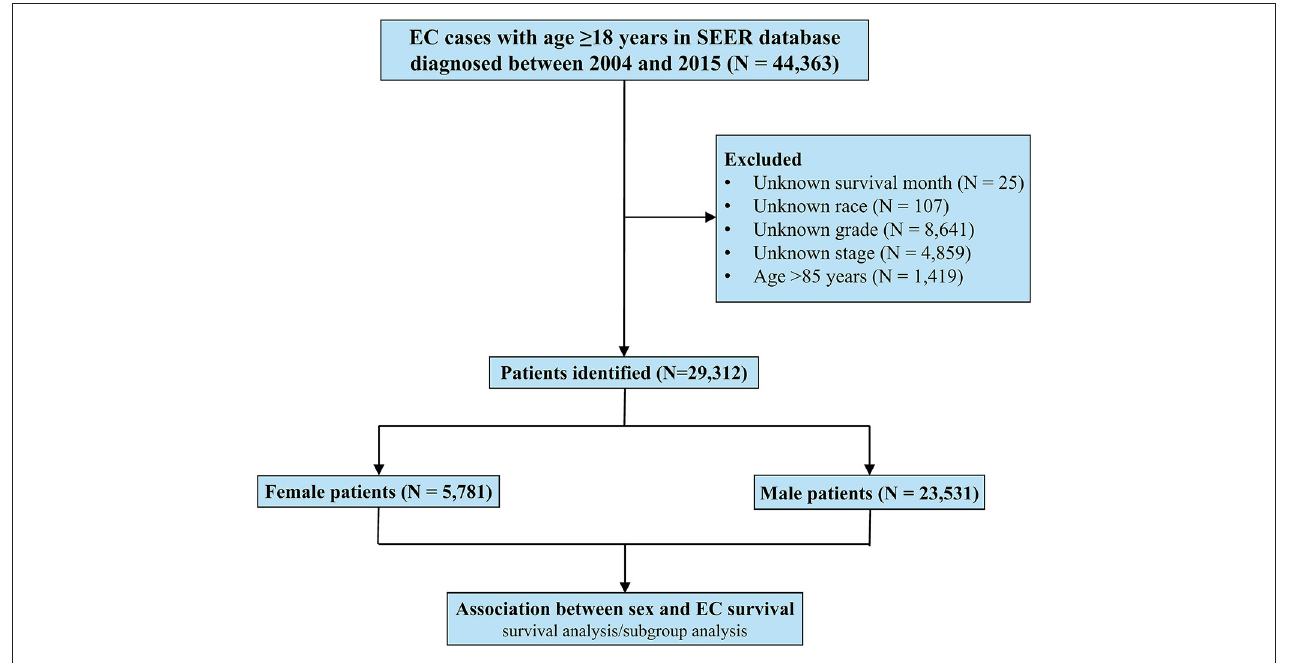
FIGURE 1 | Patient selection